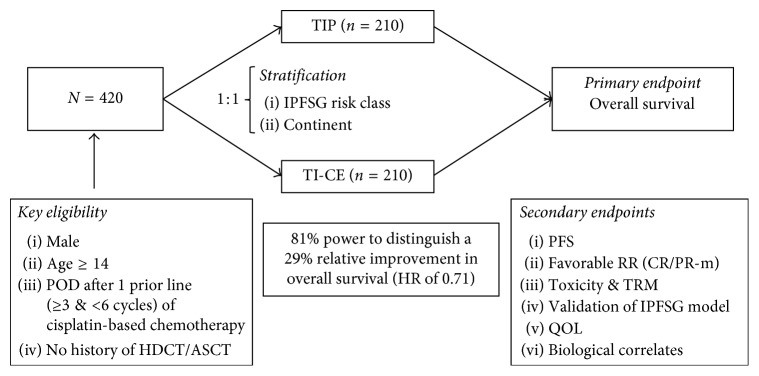
Study design of the TIGER trial (Alliance 0311012; EORTC 1407). POD, progression of disease; HDCT/ASCT, high-dose chemotherapy with autologous stem cell transplant; TIP, paclitaxel, ifosfamide, and cisplatin; TI-CE, paclitaxel and ifosfamide followed by high-dose carboplatin and etoposide; IPFSG, International Prognostic Factors Study Group; PFS, progression-free survival; response rate; CR, complete response; PR-m, partial response with normal tumor markers; TRM, treatment-related mortality; QOL, quality of life.